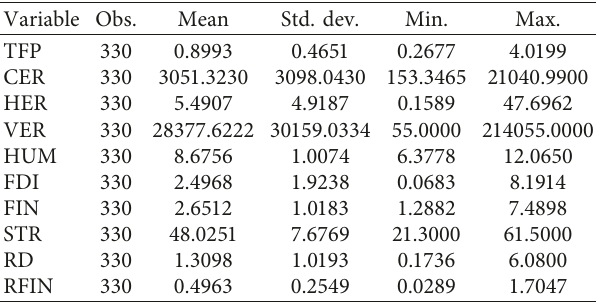
Table 3: Descriptive statistics of variables.